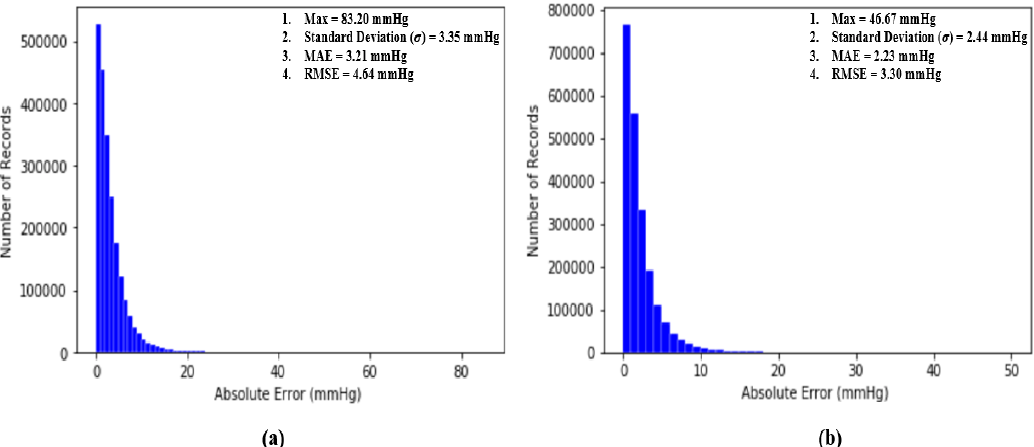
Figure 11. ( a ) Distribution of absolute error across 2,176,188 records of SBP and ( b ) distribution of absolute error across 2,176,188 records of DBP.